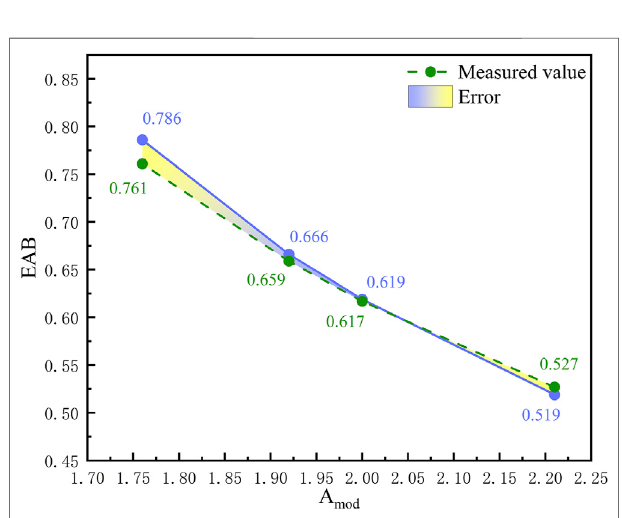
FIGURE 8 | The distribution of evaluation reference